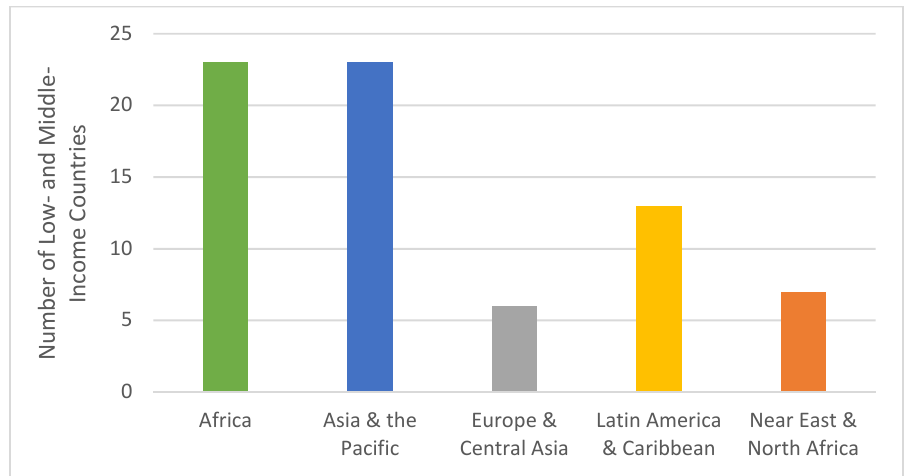
Figure 1. Number of LMICs with dietary surveys conducted during 1980–2019 by geographical region according to the FAO/WHO GIFT inventory of surveys. Data shown reflect the situation as of May 2022. Geographic regions are defined according to the FAO operational classification. Only LMICs are included for all regions, including Europe and Central Asia.